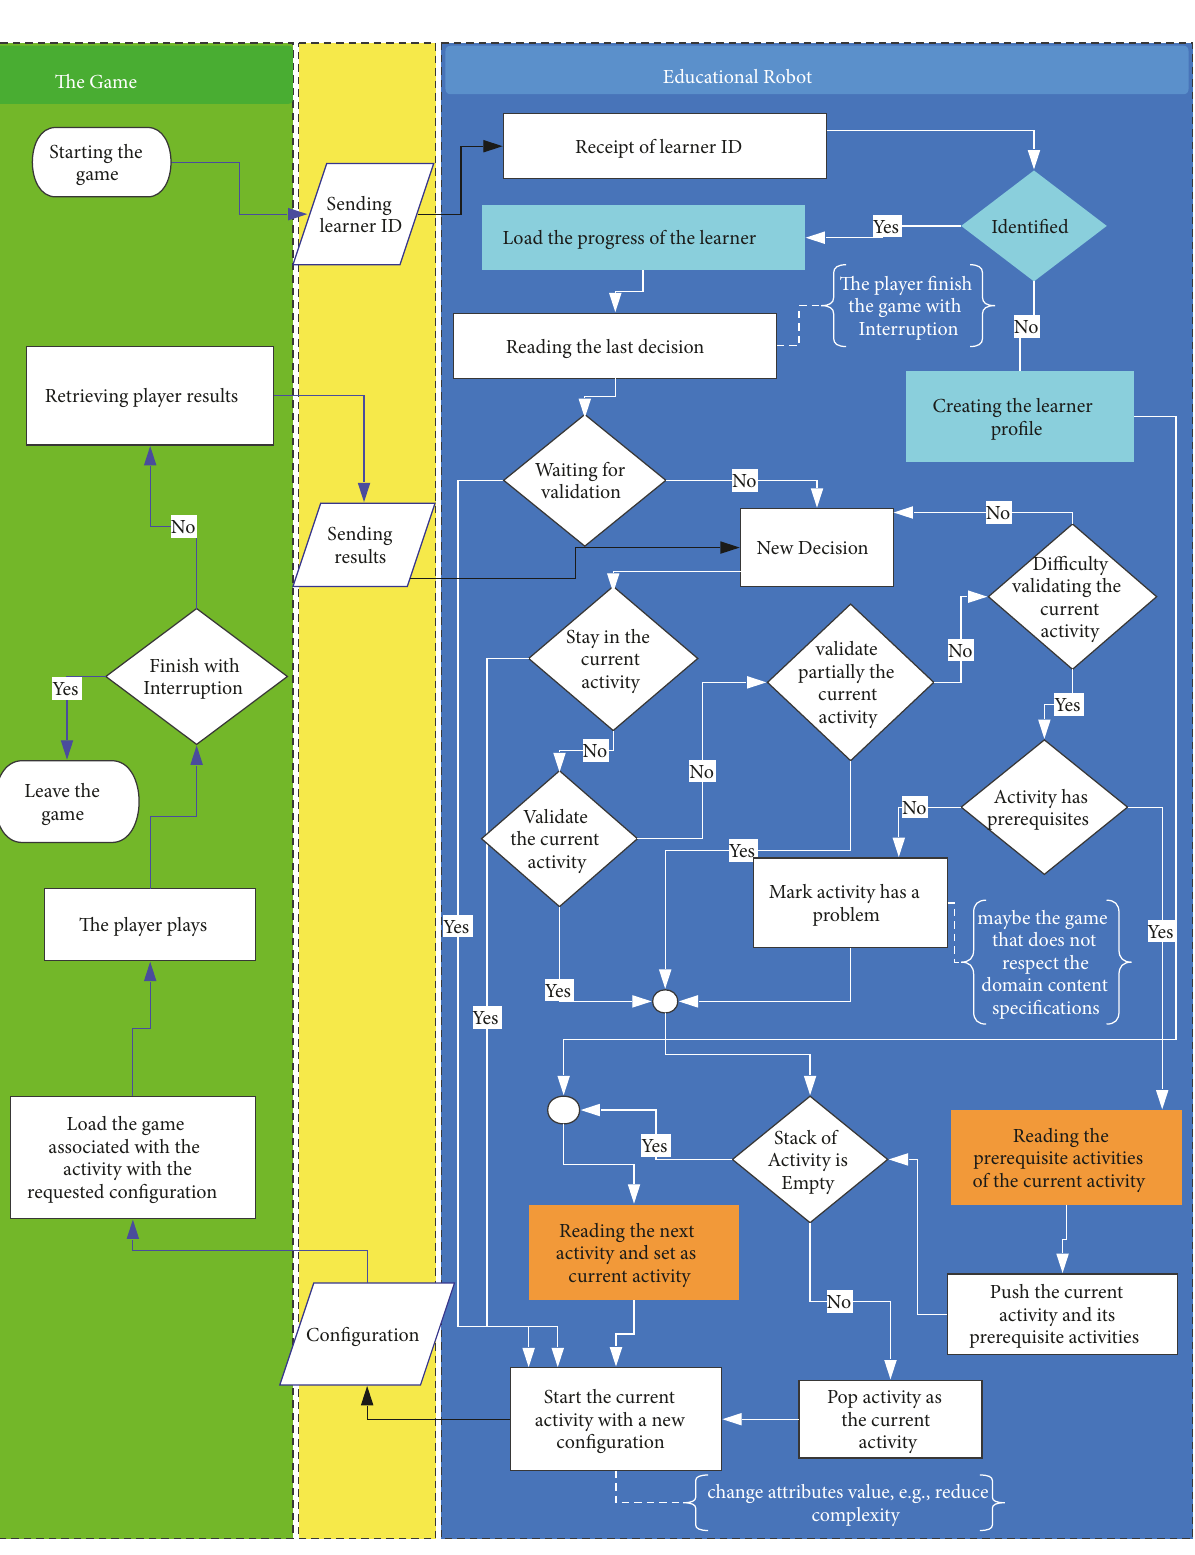
Figure 7: An example that shows implementation of the educational robot and how it communicates with the